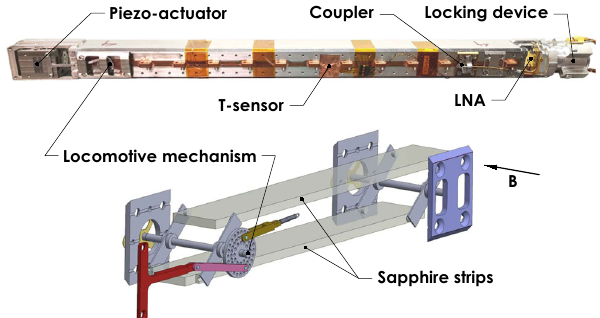
Fig. 1 | A photograph of the elements of a single cavity assembly (top) and a technical drawing of CAST-CAPP tuning mechanism with the two sapphire strips (bottom). The static B- fi eld is shown by the arrow and is parallel to the two axes of the tuning